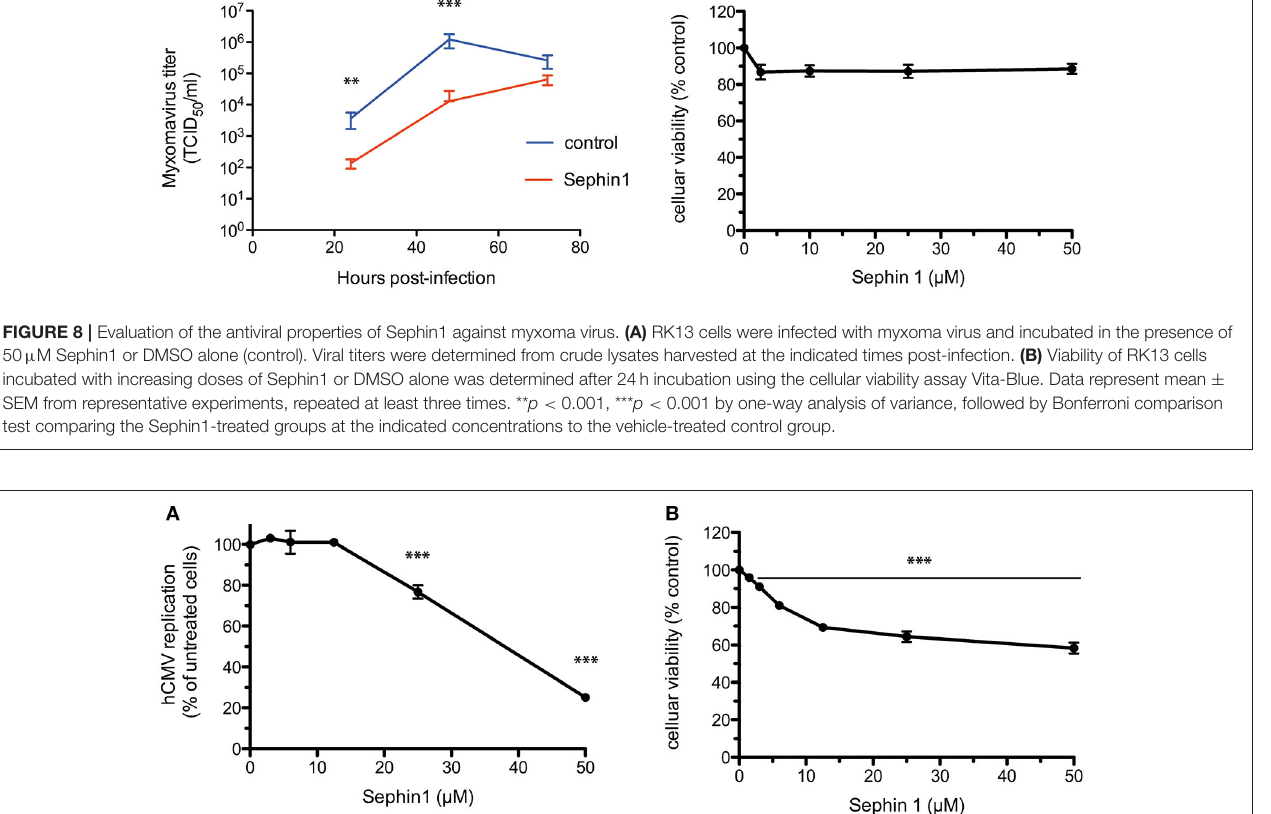
FIGURE 9 | Evaluation of the antiviral properties of Sephin1 against human cytomegalovirus. (A) ARPE-19 cells were infected with a recombinant strain of hCMV expressing ANCHOR3 and incubated with increasing doses of Sephin1 or DMSO alone. After 72h, virus replication was determined by automated counting of GFP foci. (B) Viability of ARPE-19 cells incubated with increasing doses of Sephin1 or DMSO alone was determined after 72h incubation using the cellular viability assay Vita-Blue. Data represent mean ± SEM from representative experiments, repeated at least three times. *** p < 0.001 by one-way analysis of variance, followed by Bonferroni comparison test comparing the Sephin1-treated groups at the indicated concentrations to the vehicle-treated control